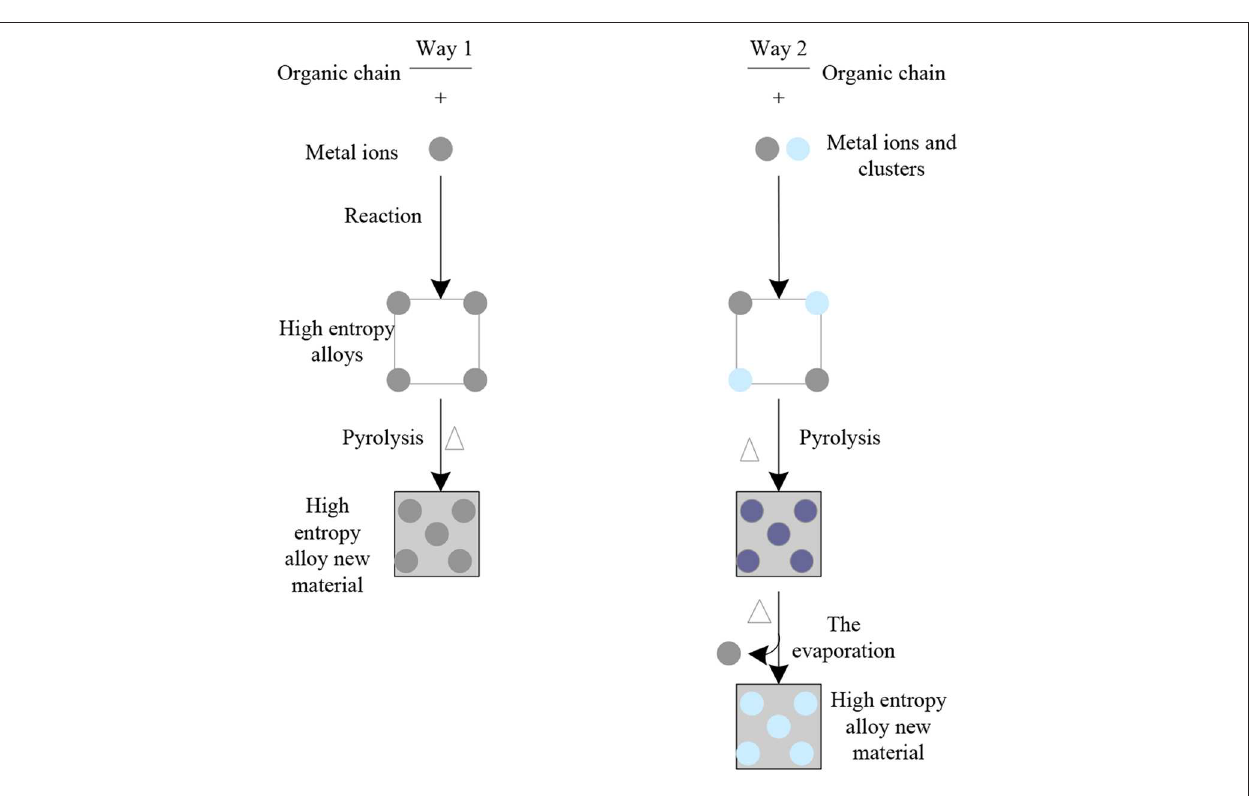
FIGURE 9 | Schematic diagram of preparation of new high entropy alloy